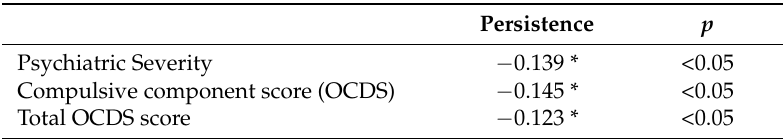
Table 4. Statistically significant correlations between Persistence (TCI-R) and severity factors of the EIDA, OCDS and EuropAsi Scales. (* p <